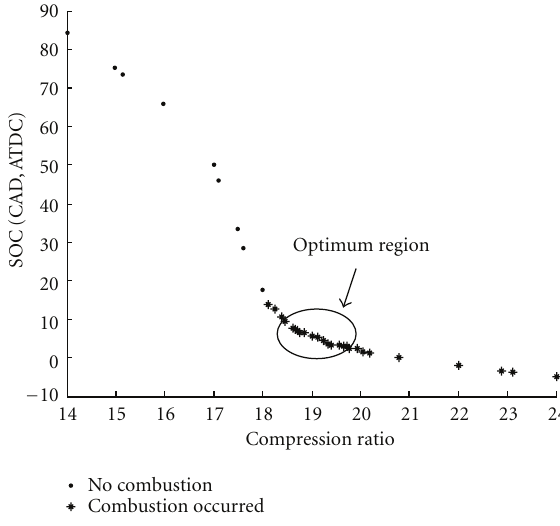
Figure 17: SOC versus compression ratio calculated by GA.